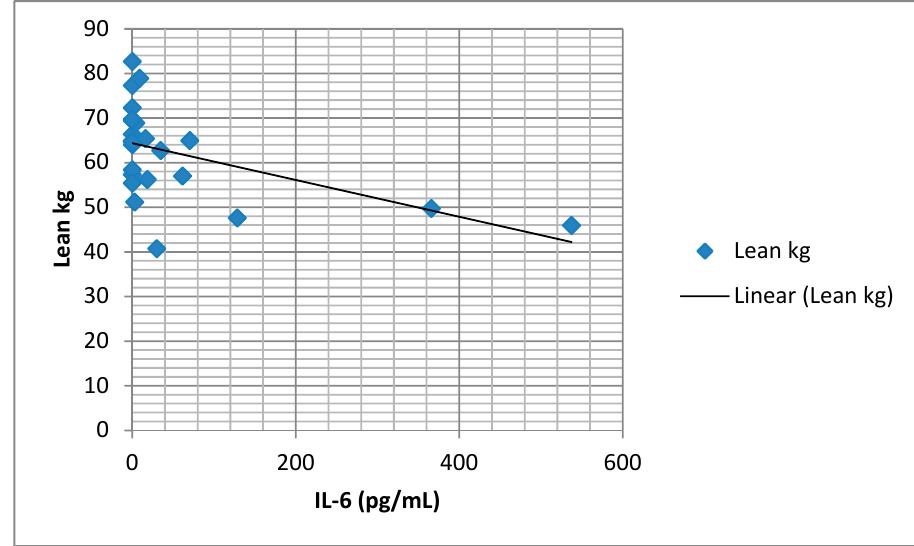
Figure 6. Correlation of serum IL-6 and lean body mass (FFM) ( r = − 0.501, p = 0.013).